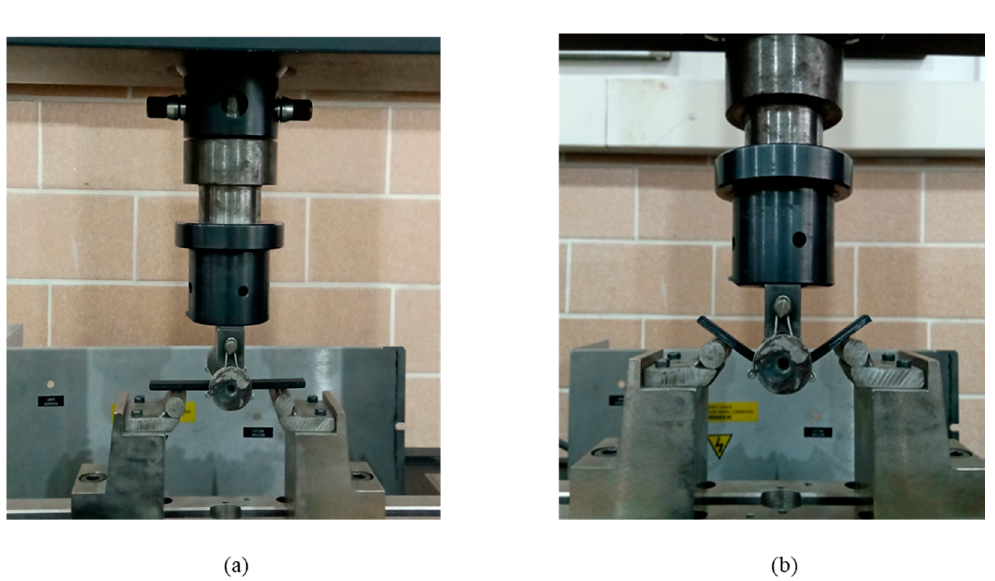
Figure 7. ( a ) Experimental Setup before the application of load; ( b ) after the application of